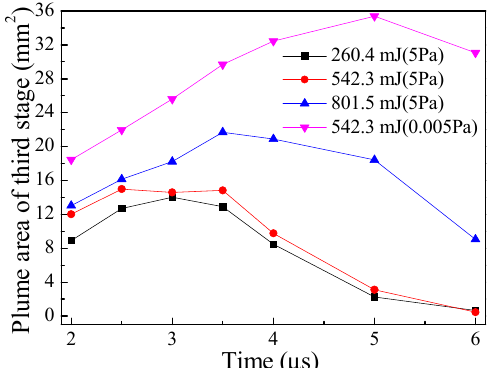
Figure 23. The plume area of third stage variation with time at different laser energies (ambient pressure 5 Pa and 26.5% Al).